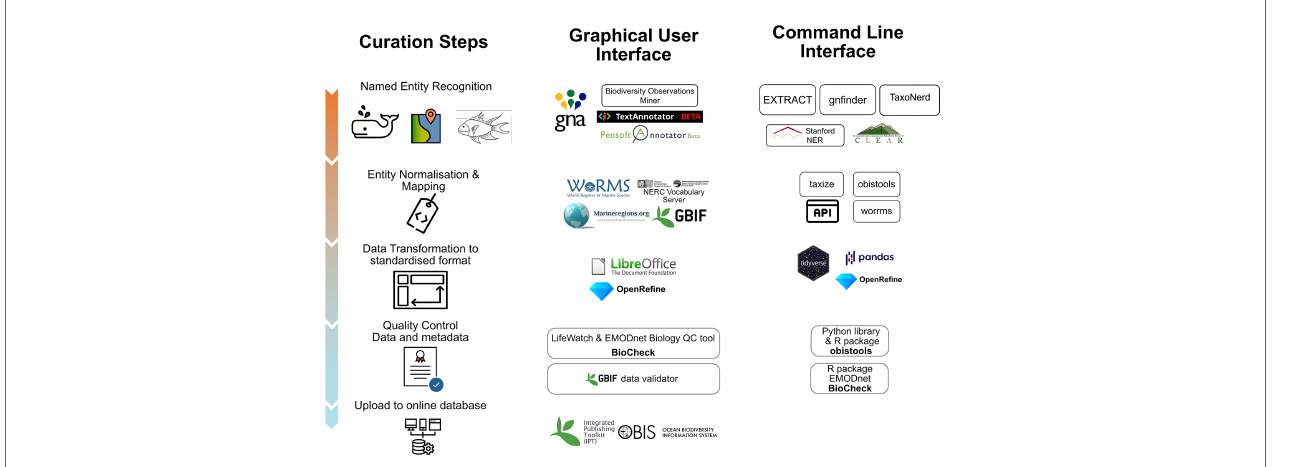
FIGURE 3 | The curation process of marine historical biodiversity documents: on the left column are the required steps starting from the scanned document (usually a PDF file) and ending with the data publishing step. Two approaches are presented: in the middle column are the GUI tools whereas on the right column are the CLI and/or the executable programming tools. Note that the list of given examples is non-exhaustive. Icons used from the Noun Project released under CC BY: Whale by Alina Oleynik, Fish by Asmuh, tag code by vigorn, pivot layout by paisan, Certificate by P Thanga Vignesh, web service by mynamepong